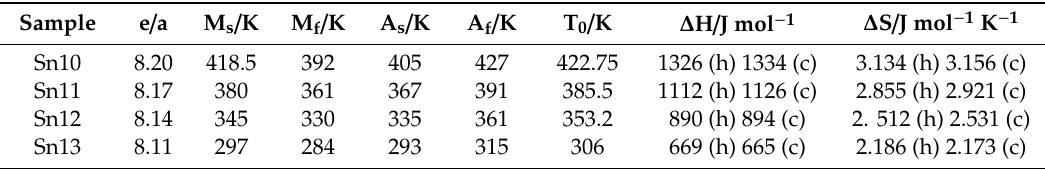
Figure 4. Di ff erential scanning calorimetry (DSC) cyclic scans for samples labeled Sn10, Sn11, Sn12, and Sn13 at a heating / cooling rate of 10 K / min. Arrows indicate heating (up: austenite to martensite) and cooling (down: martensite to austenite). Table 2. Characteristic structural and hysteretic temperatures ( ± 1 K): (h) and (c) indicate calculated on heating or cooling.